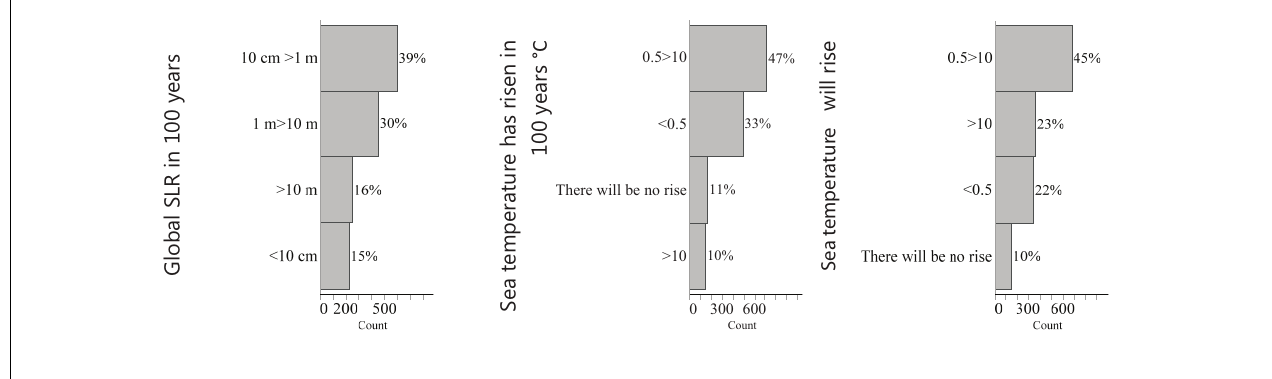
FIGURE 4 | Responses to the questions: What do you think the global average sea level rise is likely to be, if at all, over the next 100 years? By how much do you think will the sea temperature around the coasts rise?